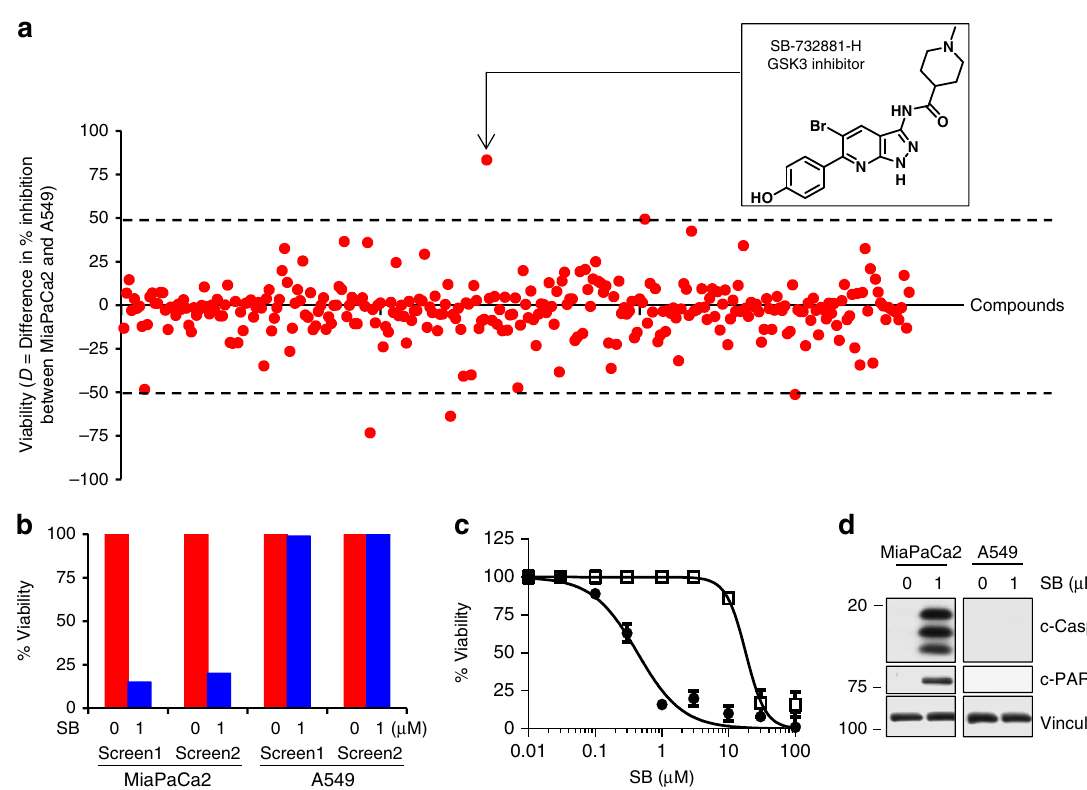
Fig. 1 Kinome screen identi fi es GSK3 inhibitor that suppresses mutant KRas-dependent cells. a MiaPaCa2 (mutant KRas-dependent) and A549 (mutant KRas-independent) human tumor cells were treated for 72 h in 96-well plates with 304 kinase inhibitors (1 µ M) using a one well-one inhibitor format. D [(% inhibition of viability of MiaPaCa2) − (% inhibition of viability of A549)] was determined for each compound based on the average of two screens. b Effects of SB on percent cell viability from both screens. c IC 50 determination of in-house synthesized SB (experiment done three times). d Western blots showing SB-induced caspase-3 activation and PARP cleavage in MiaPaCa2 but not A549 cells (experiment done three